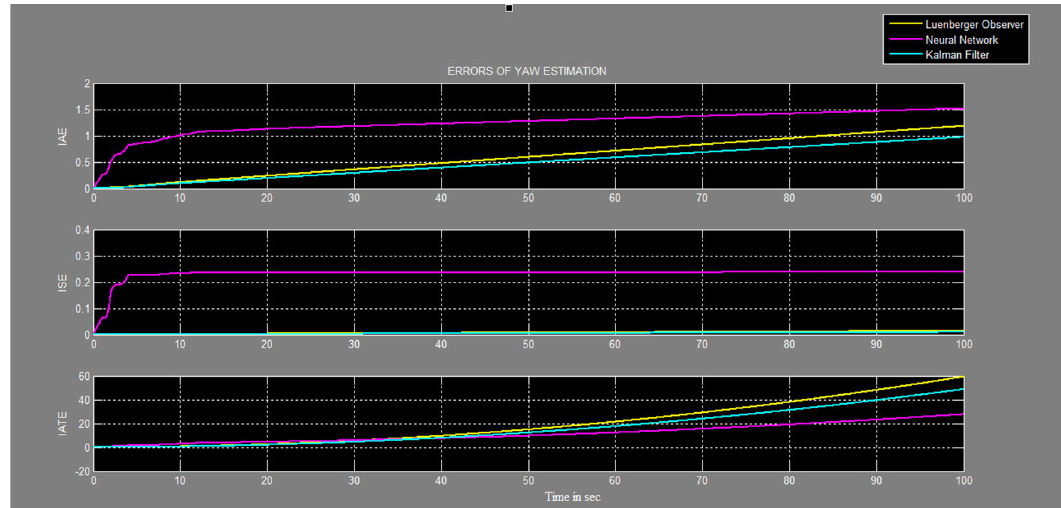
Figure 18. Comparative graphs of errors in the estimation of yaw with three different systems.